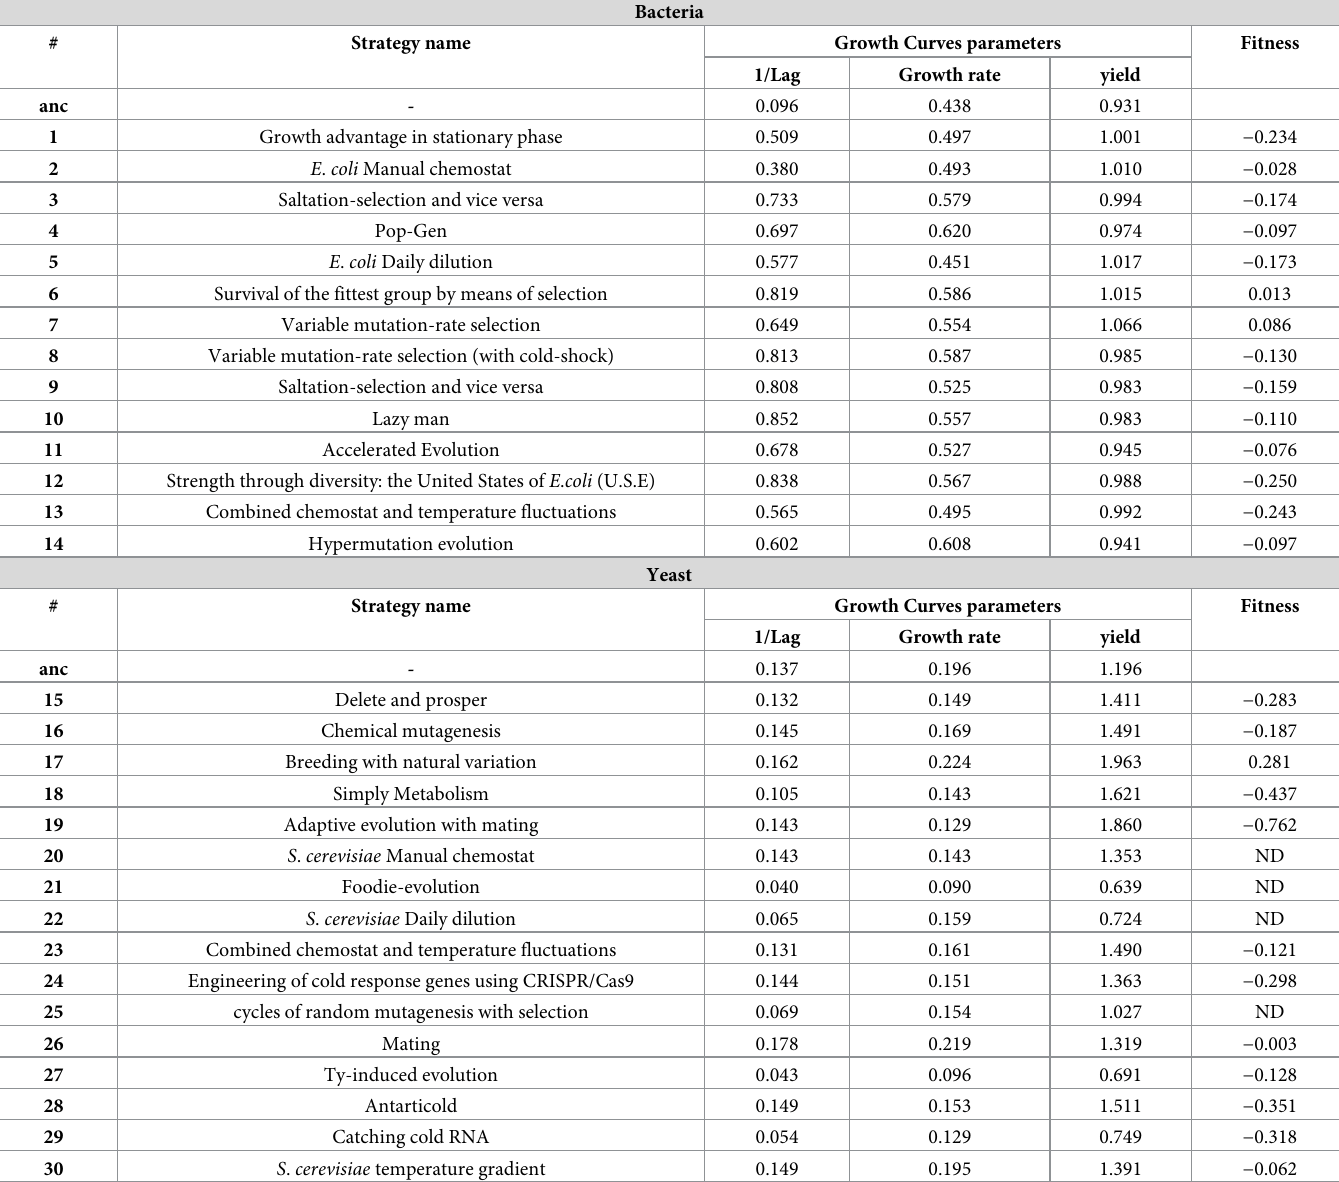
Table 1. Summary of strains’ performance. For each strategy and the ancestral strain the growth parameters (1/lag, growth rate, and yield) calculated from individual growth curves (see S3 Text ) are shown. Fitness values are calculated using a maximum likelihood algorithm (see S3 Text ) based on the pool competition. Fitness was only calculated for strains with more than 10 reads at the beginning of the competition (otherwise ND is